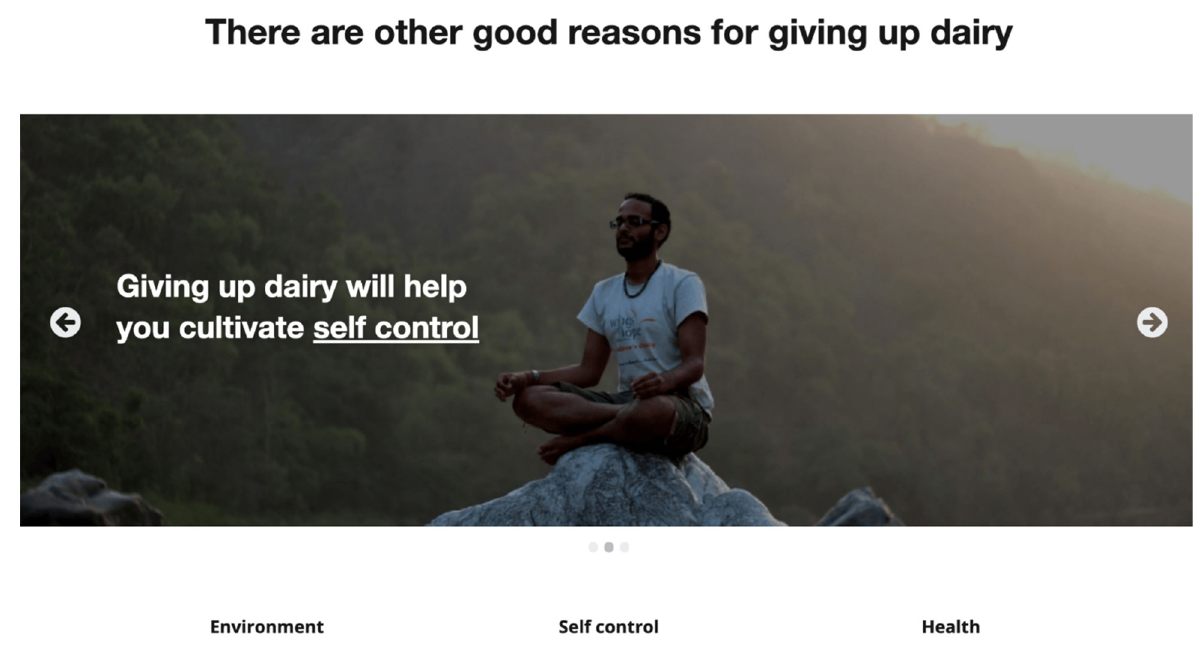
Figure 1. Jain Vegans co-founder Sagar Shah in meditation to illustrate how giving up dairy represents a form of self-control ( sam ̣ yama ) (Source: jainvegans.org).